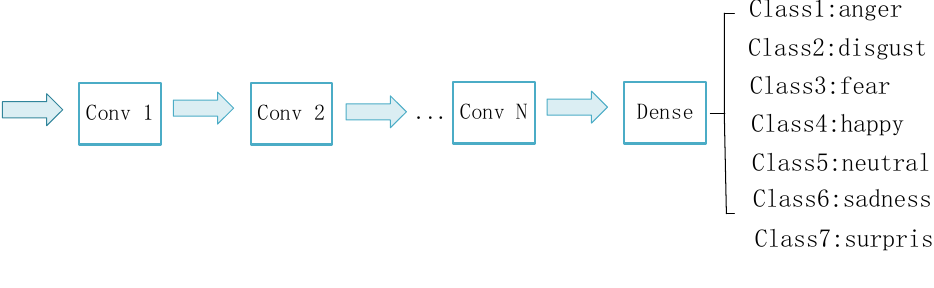
Figure 9 . Classification Network